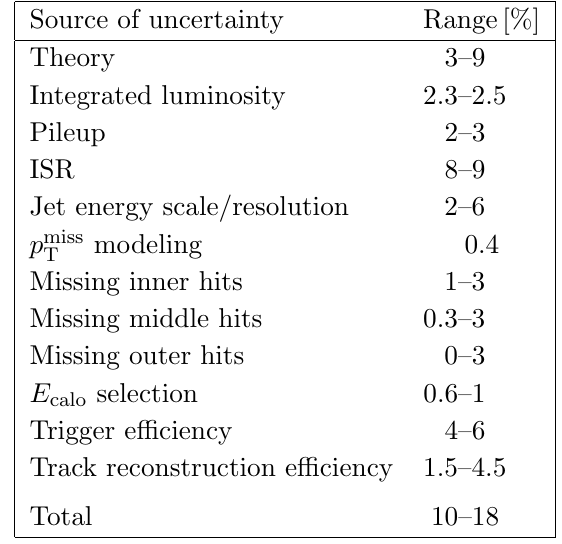
Table 3 . Summary of the systematic uncertainties in the signal yields. The ranges represent either the variation with chargino mass and lifetime or with the data-taking period used to calculate the uncertainty, depending on the source of each uncertainty as described in the